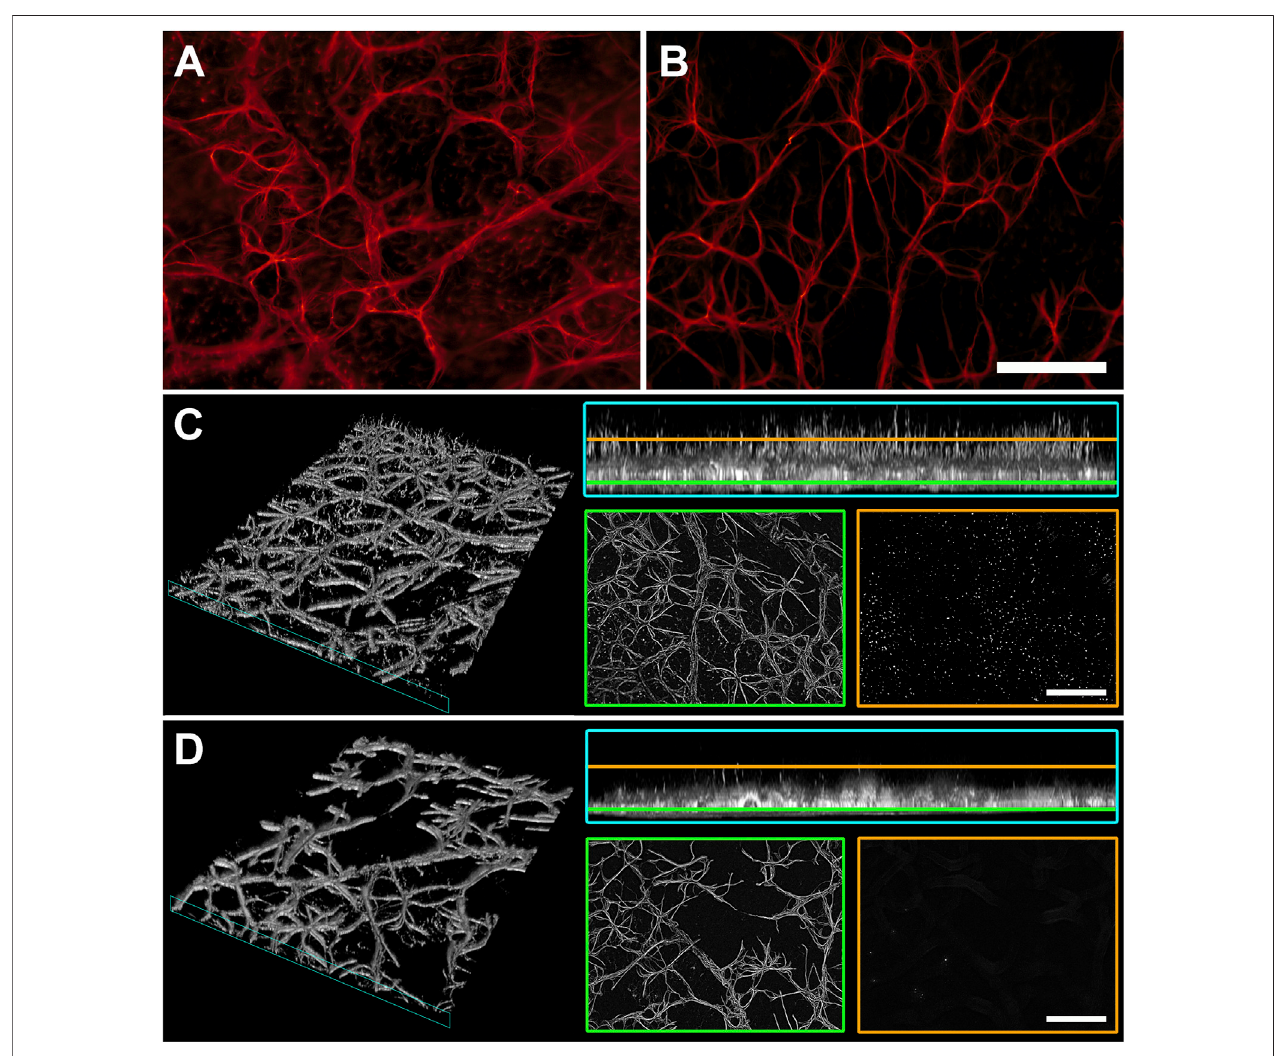
FIGURE5| GFAPimmunostaininginwholemountretinasofD2 (A) andD2+LG (B) micefortheevaluation ofmacrogliaactivation. (C , D) virtual3Dreconstructions of 70 µm z-stacks of D2 and D2+LG retinas, respectively, displaying GFAP-immunopositive processes in the retinal thickness (cyan insets) and surface projections distancing 10 µm (yellow) and 45 µm (green) from the uppermost focal plan. Scale bars, 100 µm.